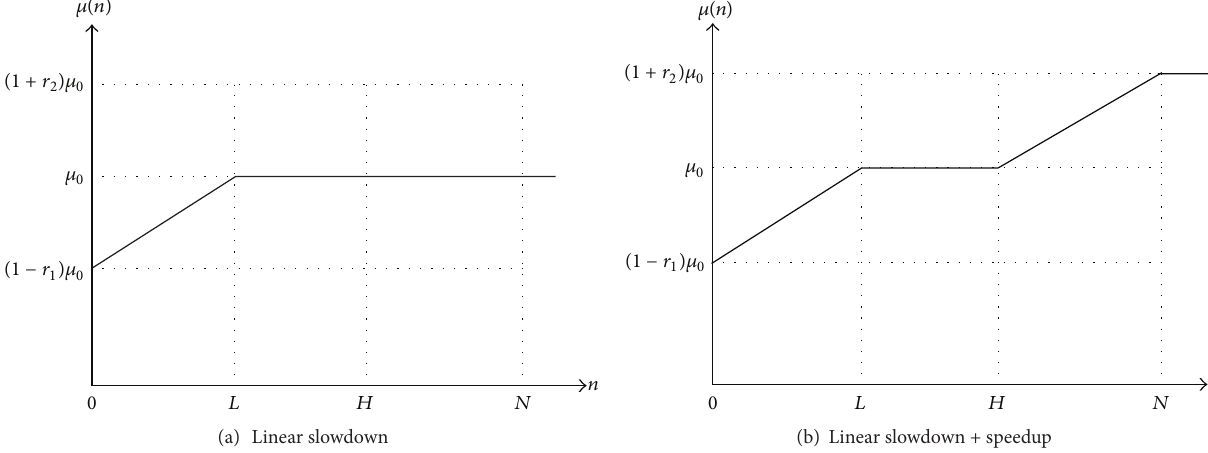
Figure 3: The playout rate functions for linear slowdown and linear slowdown+speedup playout systems.